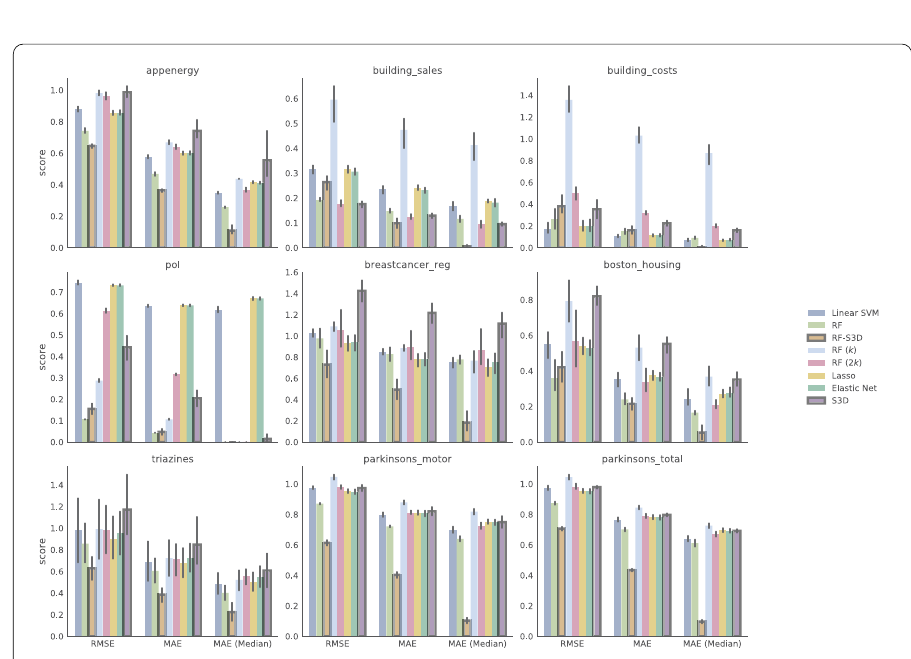
Figure 4 Regression performance on 5-fold cross validation in nine datasets. Error bars here indicate one standard deviation. A higher bar (greater value) means worse performance